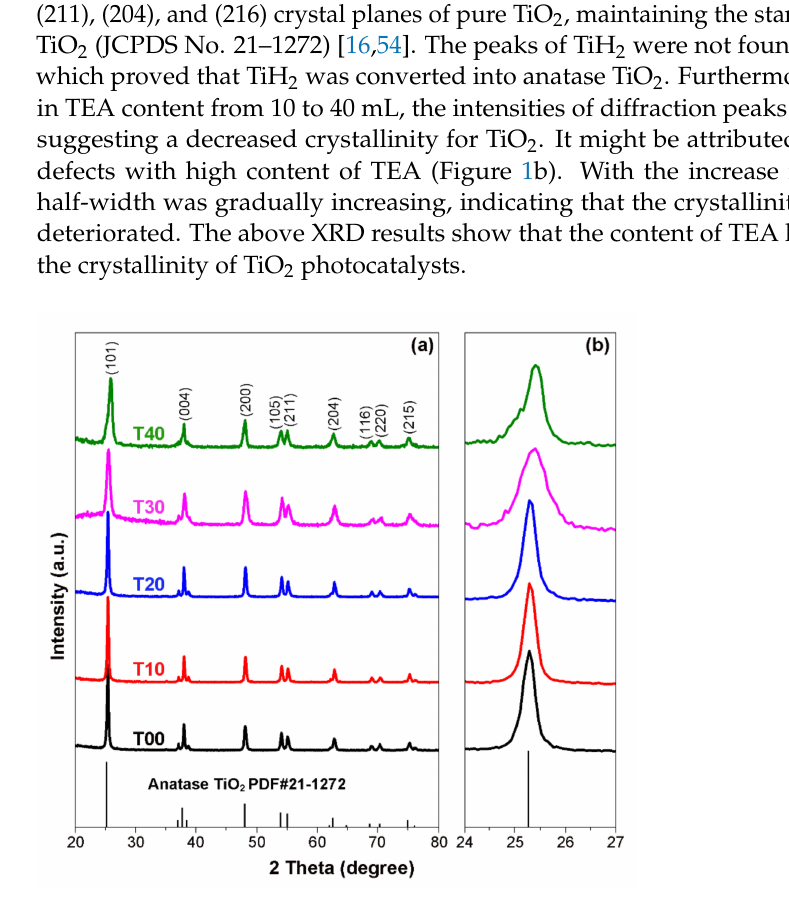
Figure 1. ( a ) XRD spectra of TiO 2 photocatalysts obtained by solvothermal treatment of the sol at different triethanolamine concentrations and ( b ) enlarged XRD